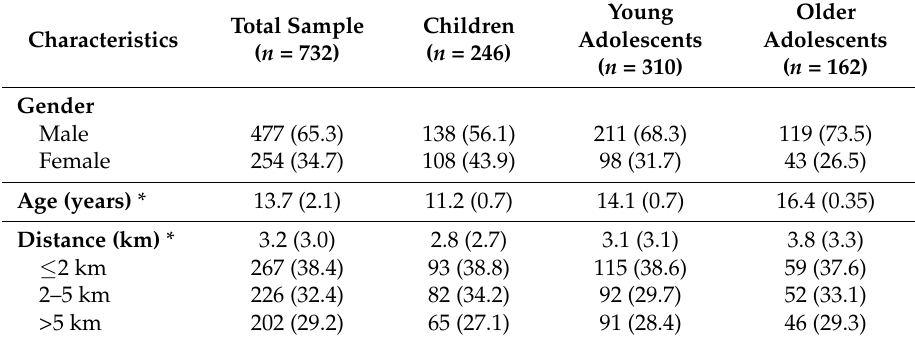
Table 1. Sociodemographic data of the participants.